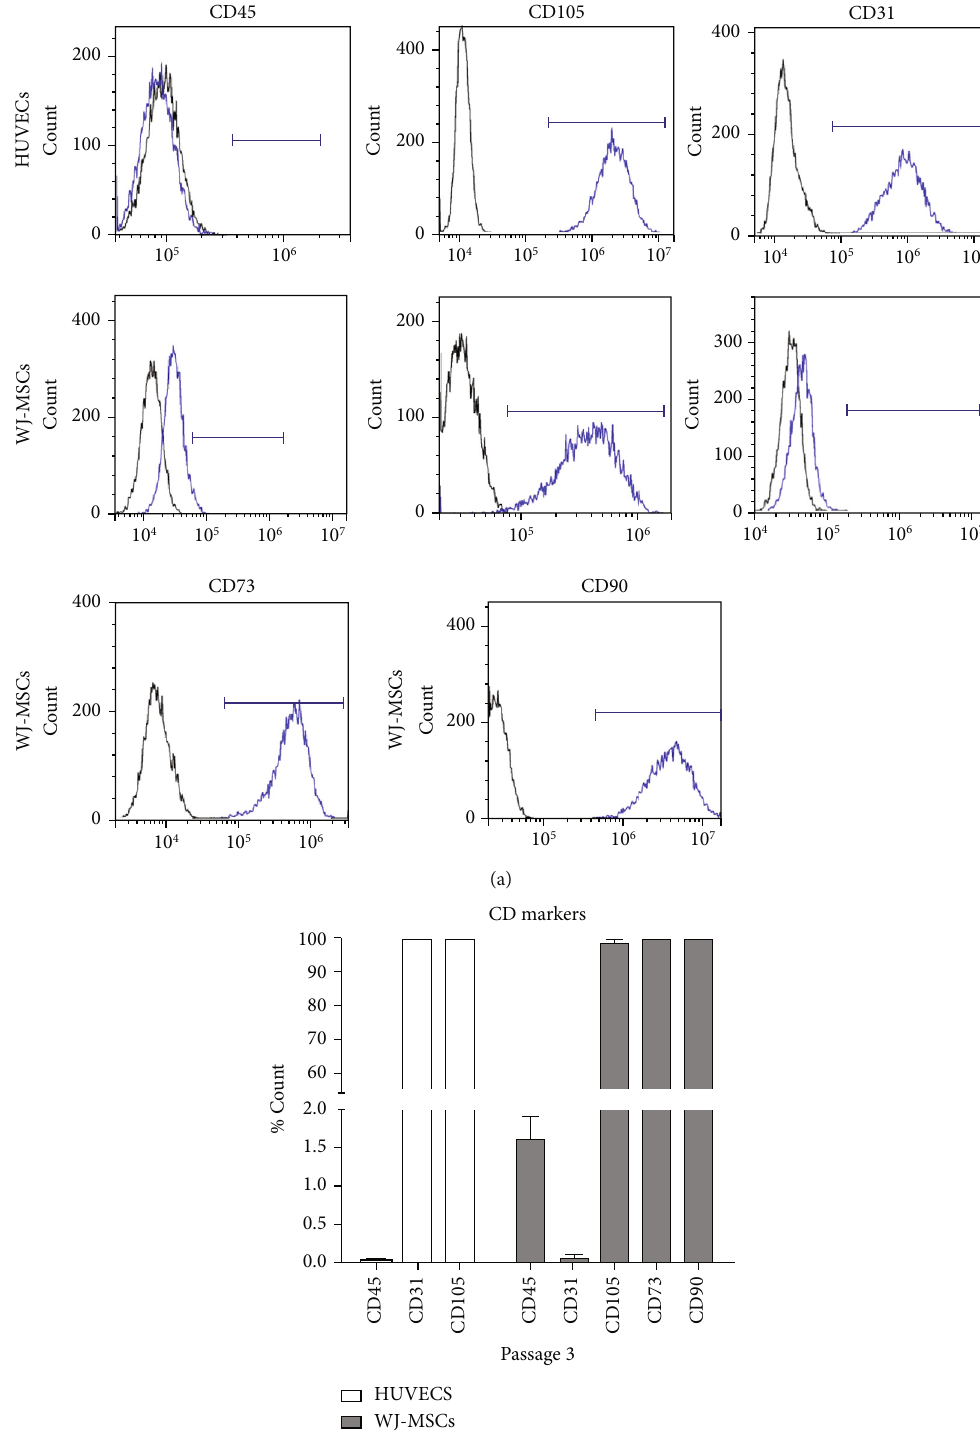
Figure 3: Puri fi cation of HUVECs and WJ-MSCs obtained by using a single umbilical cord with xeno-free cell isolation and expansion strategy. (a) Representative fl ow cytometry analysis of expanded HUVECs and WJ-MSCs stained with antibodies directed against human antigens speci fi c for pan leukocyte (CD45), ECs (CD31), and MSCs: CD105, CD73, and CD90. (b) Percentage of HUVECs (light bar) and WJ-MSC-s (gray bar) stained positive for endothelial and MSC markers. Data were expressed as mean ± SEM ( N = 3